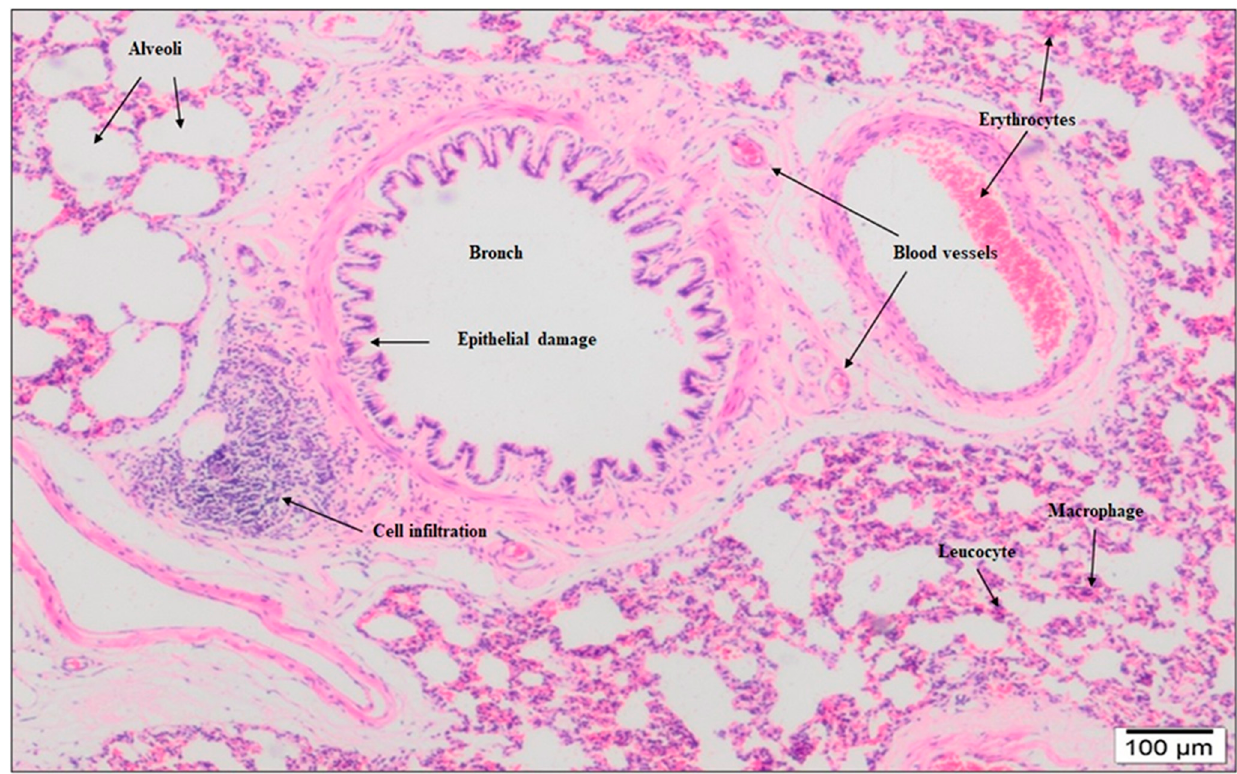
Figure 2. Based on 15% NaOCl application in lung histology, fibrosis was observed in the connective tissue around the vessels, bronchi, and bronchioles. Deteriorations were observed in the terminal and respiratory bronchioles, epithelial and subepithelial connective tissue, and muscle cells below. More peripherally, alveoli were lined with squamous and cuboidal epithelium, and interalveolar septa were found to be of increased thickness. There was local congestion in the veins. Macrophages were occasionally observed in the interalveolar spaces (10× magnification).